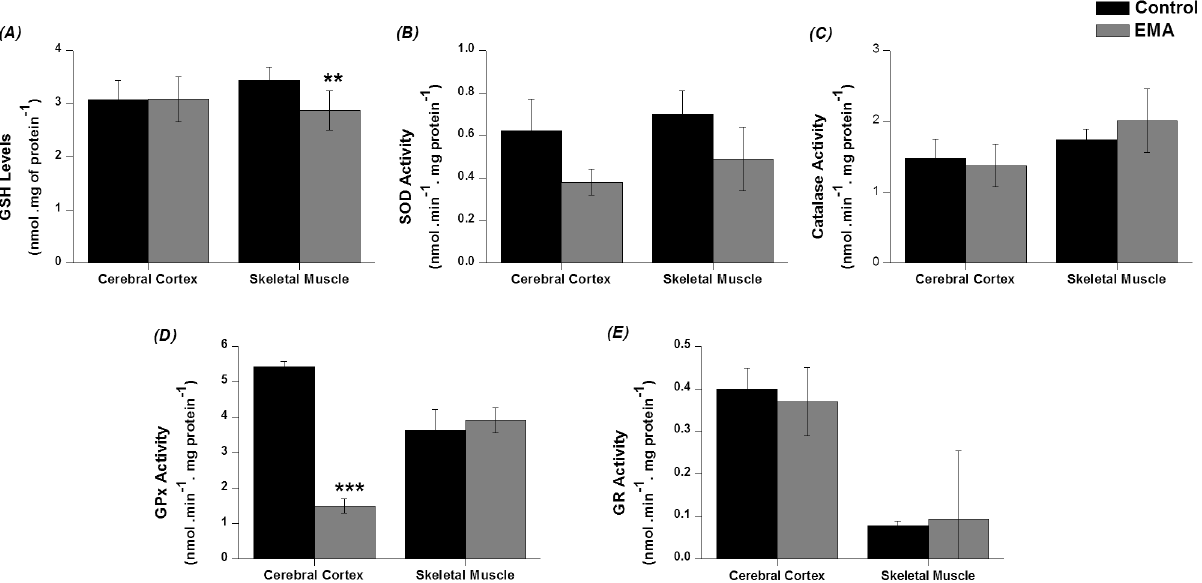
Fig 4. Effect of acute ethylmalonic acid (EMA) administration (6 μ mol/g) on reduced glutathione (GSH) (A) , superoxide dismutase (SOD) (B) , catalase (C) , glutathione peroxidase (GPx) (D) and glutathione reductase (GR) (E) activities in cerebral cortex and skeletal muscle from 30-day-old rats. The experiments were performed in duplicate and the data represent mean ± standard error of the mean and are expressed as enzyme activities: nmol. min -1 . mg protein -1 ; GSH concentrations: nmol. mg of protein -1 (n = 5 – 8 per group). ** p < 0.01, *** p < 0.001 compared to control group (Student t test for independent